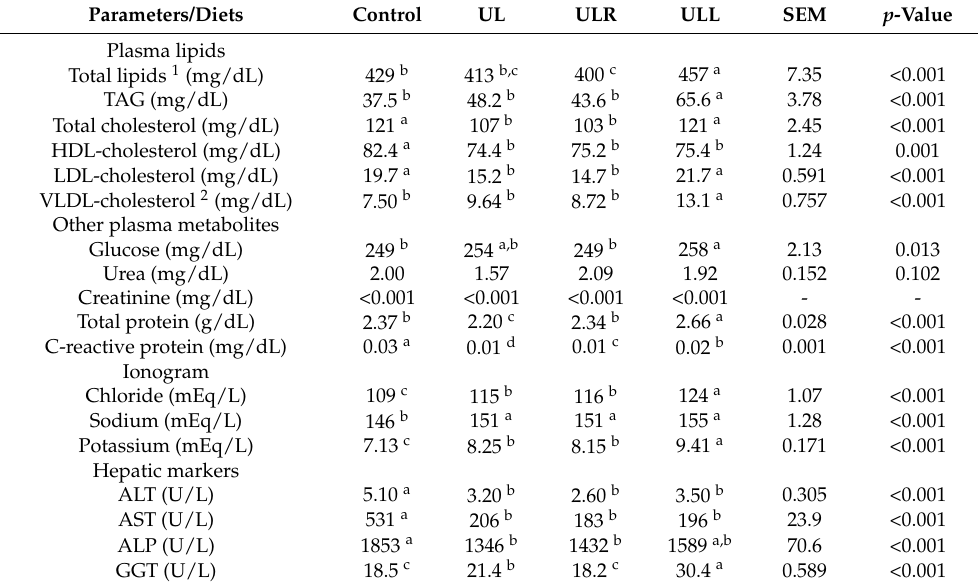
Table 2. Plasma metabolites, electrolyte balance and hepatic markers of broilers as affected by diets ( n =